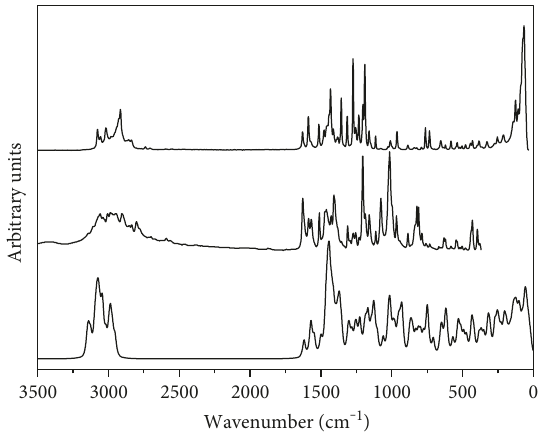
Figure 7: Raman (upper), infrared (middle), and calculated (lower) spectrum of a solid-state OMP.